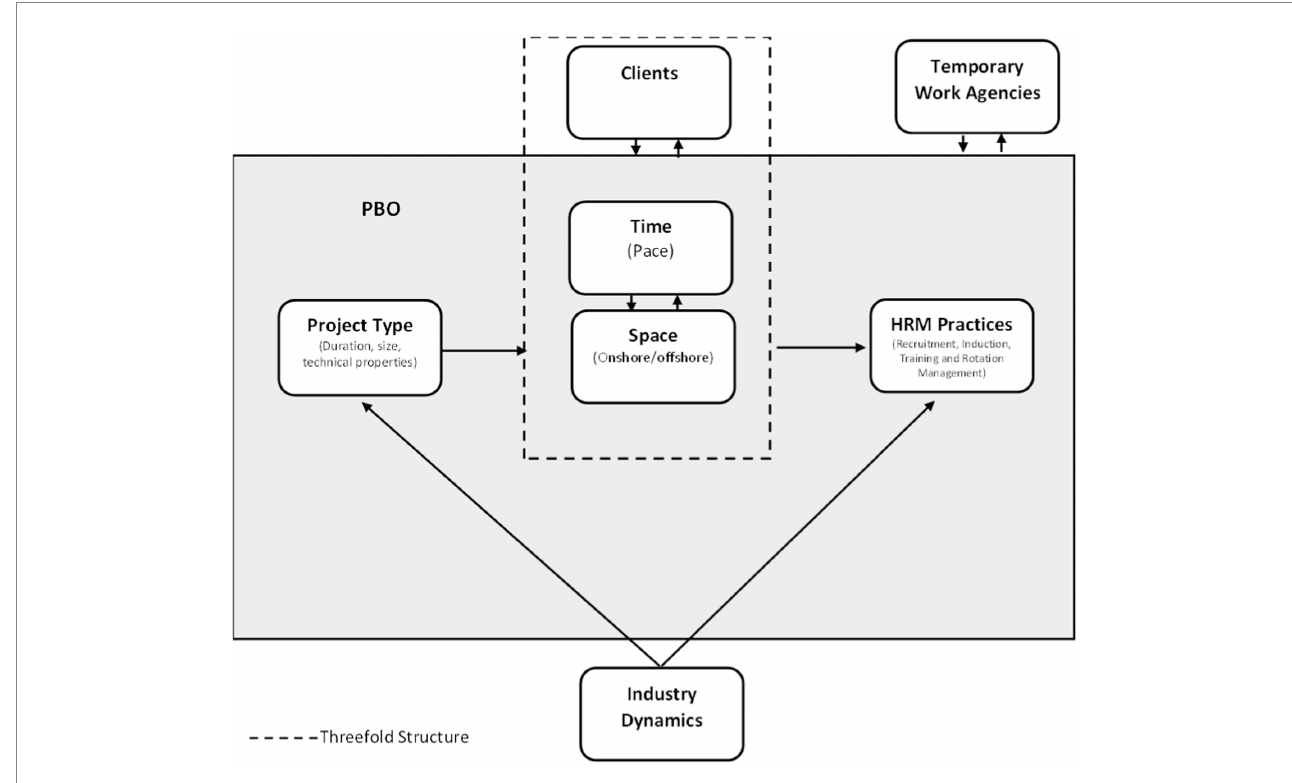
FIGURE 2 HRM practices in